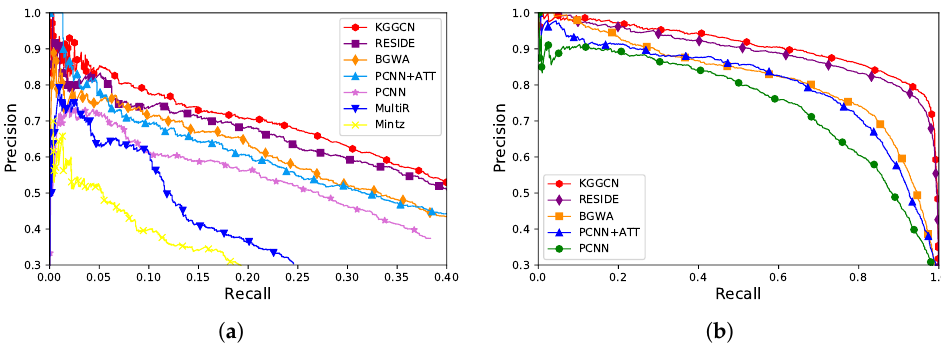
Figure 4. Performance comparison for proposed model and previous baselines in terms of precision- recall curves. ( a ) Comparison of precision-recall curves on NYT-FB dataset. ( b ) Comparison of precision-recall curves on GDS